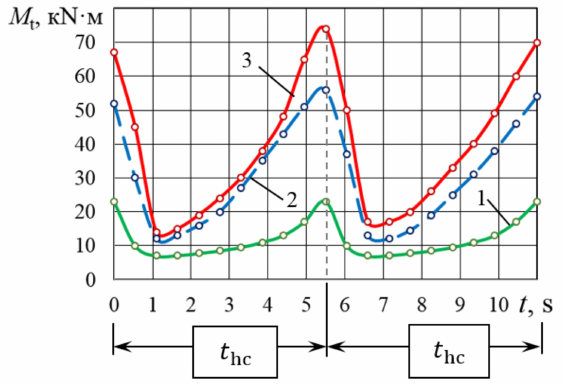
Figure 4. The torque change on the rotor during the cycle without additional rotation of the interme- diate frame t ar = 0 s: 1 − V s = 27 m/h, V c = 6 m/s; 2 − V s = 104 m/h, V c = 9 m/s; 3 − V s = 104 m/h, V c = 6